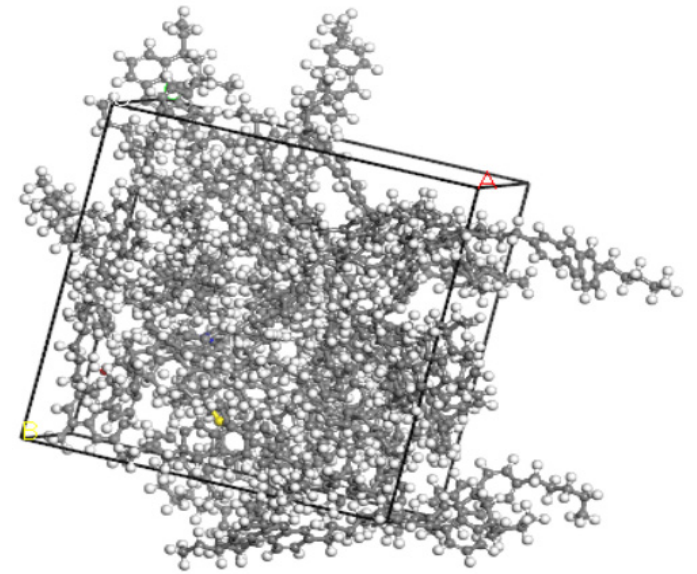
Figure 2. Asphalt molecular model.